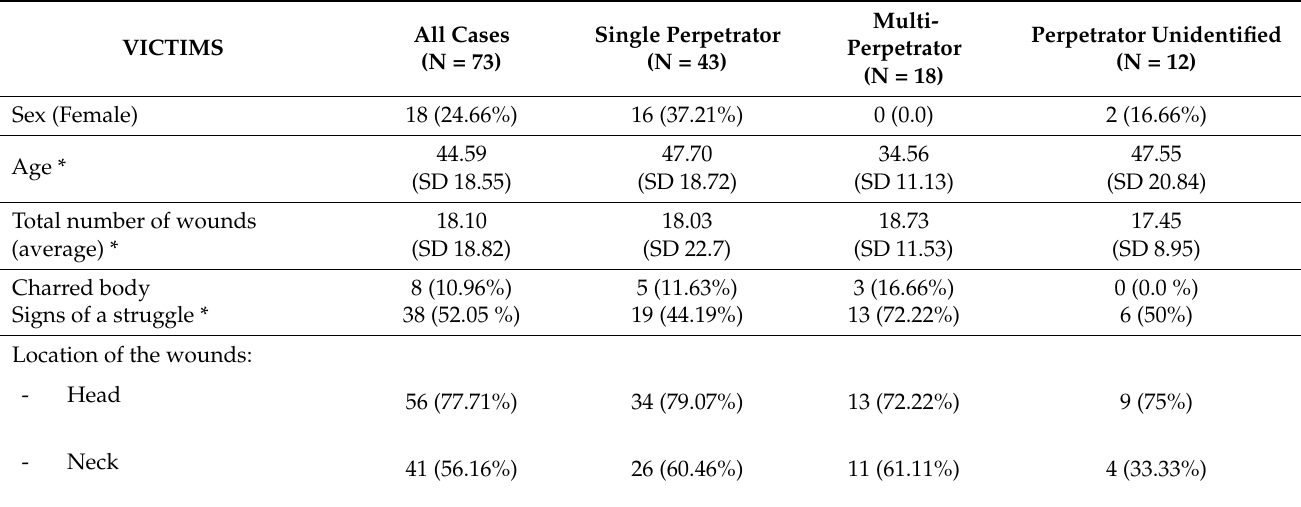
Table 2. Descriptive statistics of the